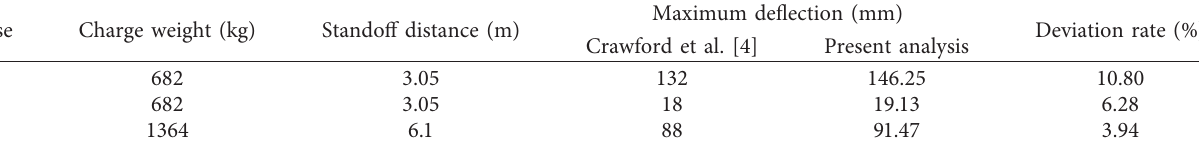
Table 4: Comparison of the maximum deflection in the analysis.